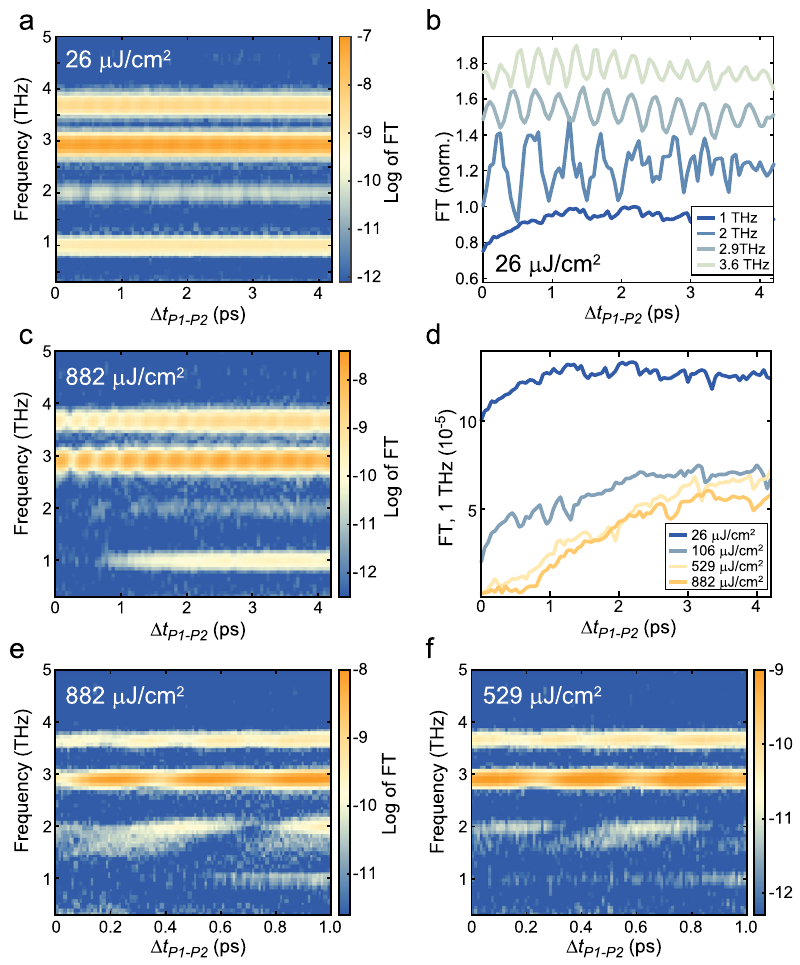
Fig. 4 Effect of Φ P1 on the coherent phonon oscillations excited in the system. a , c Natural logarithm of the FT of Δ ( Δ R / R ) oscillatory component at 1200 nm as a function of the P1 – P2 delay for Φ P1 = 26 µ J/cm 2 ( a ) and Φ P1 = 882 µ J/cm 2 ( c ). b Normalised linecuts at 1, 2, 2.9, and 3.6 THz of the data in panel ( a ). d FT amplitude for the 1 THz resonance as a function of the P1 – P2 delay for a series of Φ P1 values. e , f Data analogous to panels ( a , c ) but collected with higher temporal resolution for Φ P1 = 882 µ J/cm 2 ( e ) and Φ P1 = 529 µ J/cm 2 ( f